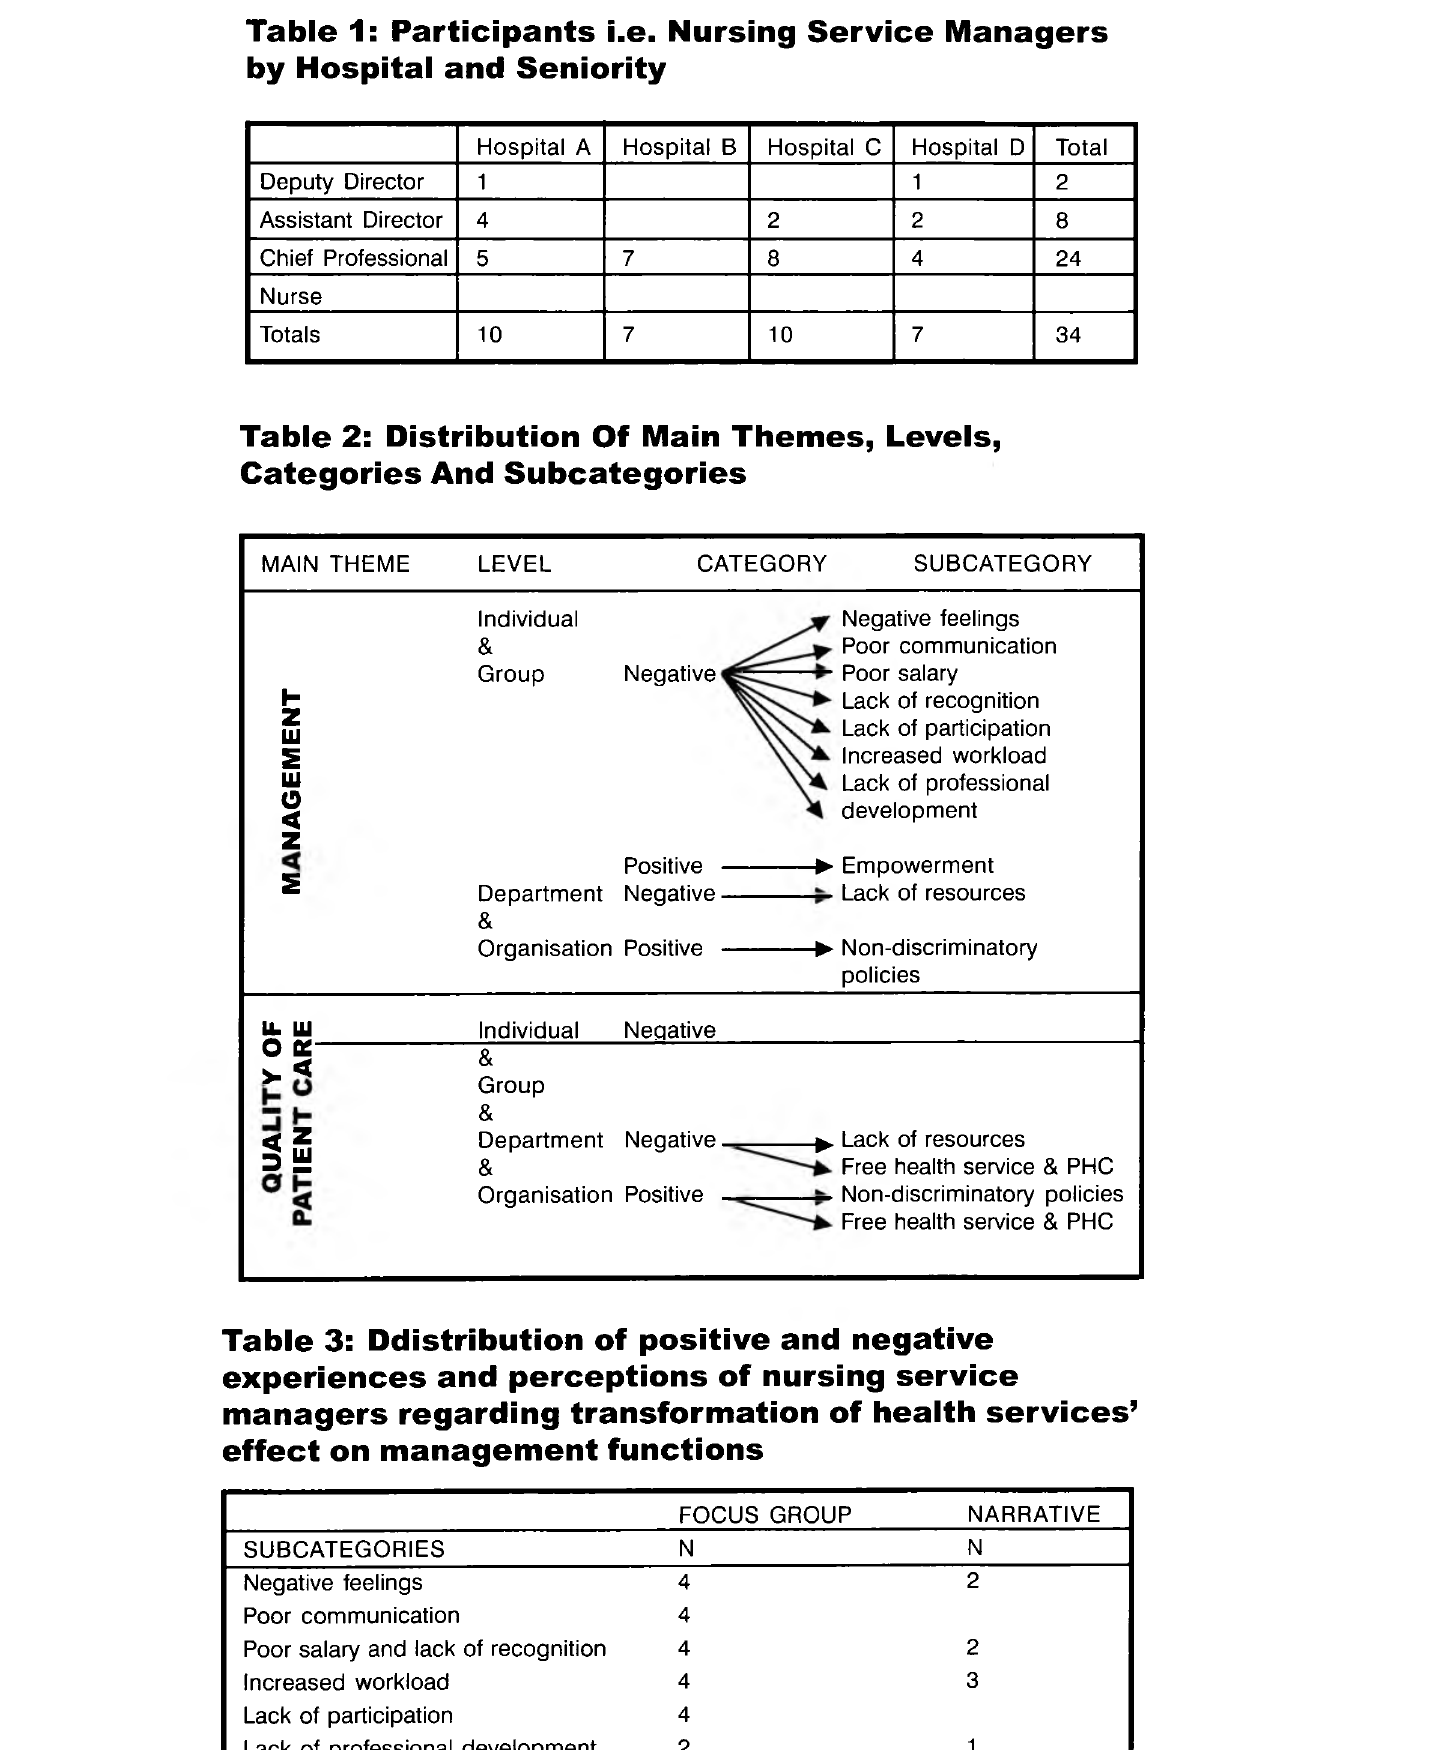
Tab le 3: D distribution of positive and negative exp erien ces and p erception s of nursing